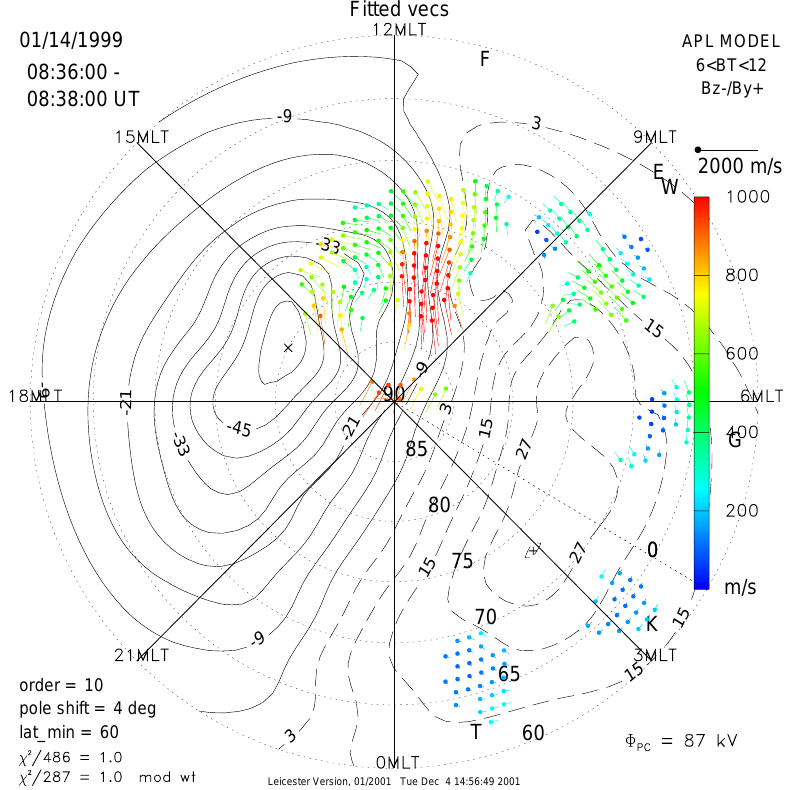
Fig. 11. SuperDARN vector plot for the interval 08:36–08:38UT. Same format as in the previous figure.